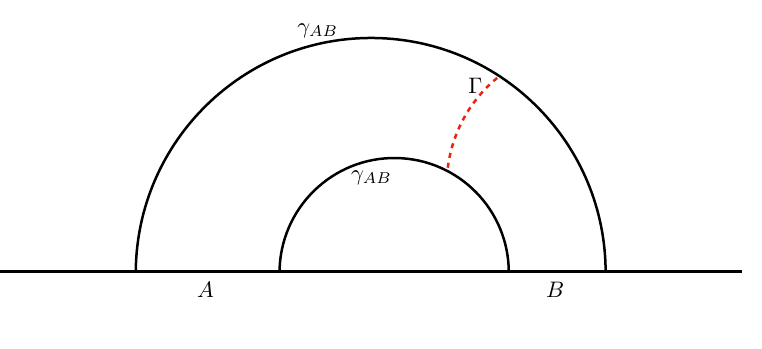
Figure 1 . Entanglement wedge for AB , bounded by the RT surfaces (cid:13) wedge cross section (cid:0) is illustrated by the red dashed